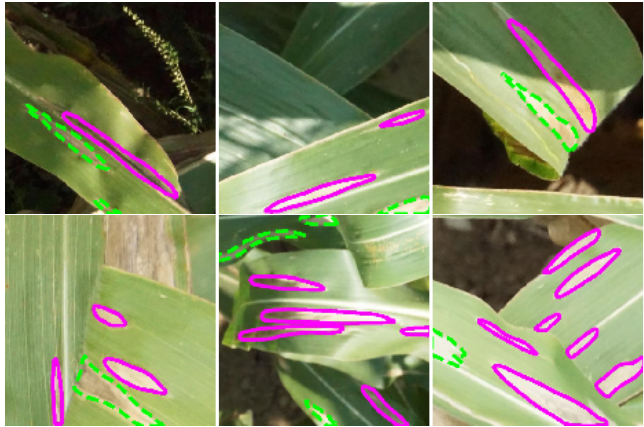
Figure 3. False negatives (dashed green outline).